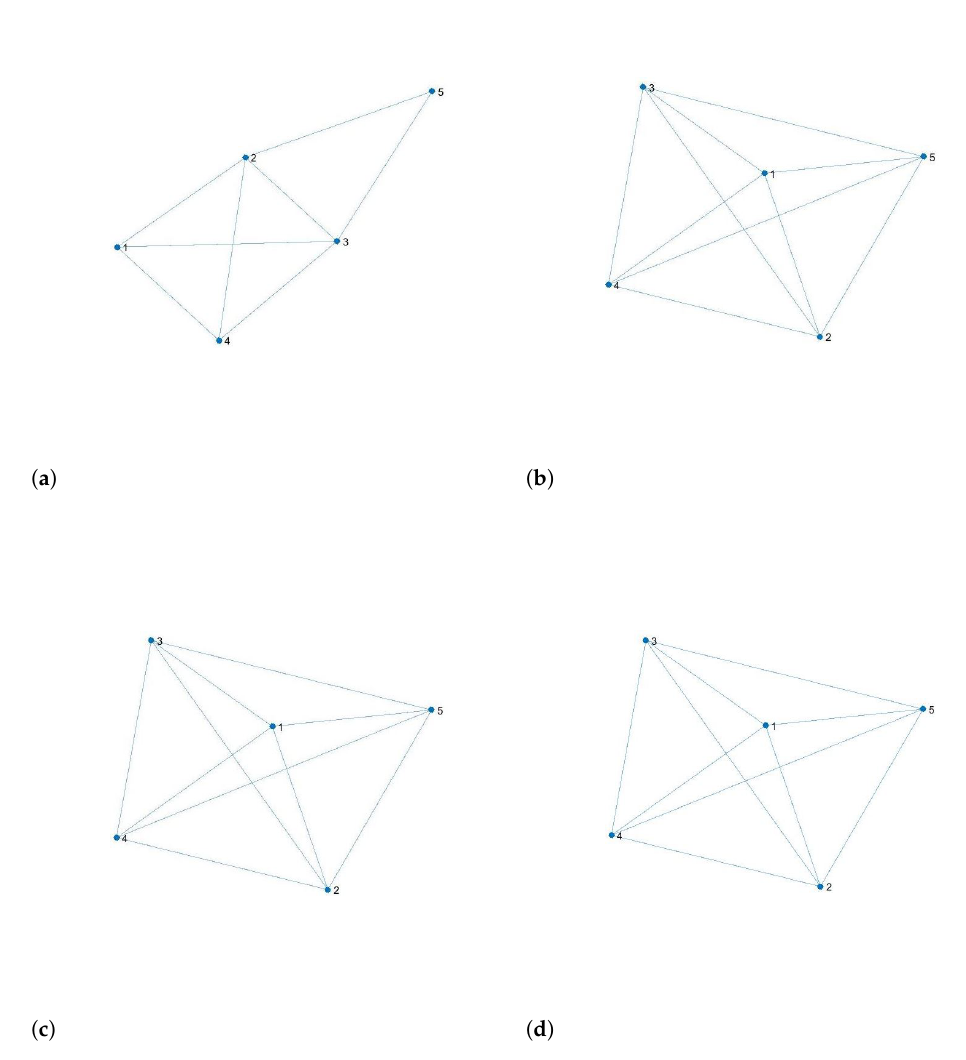
Figure 3. The simulated graphs G S ( δ ) with δ = 0.5. ( a ) The graph G S ( δ ) resulting from the BEKK model; ( b ) the graph G S ( δ ) resulting from the modified BEKK model; ( c ) the graph G S ( δ ) resulting from the DCC model; ( d ) the graph G S ( δ ) resulting from the modified DCC model. Vertex number refers to the associated